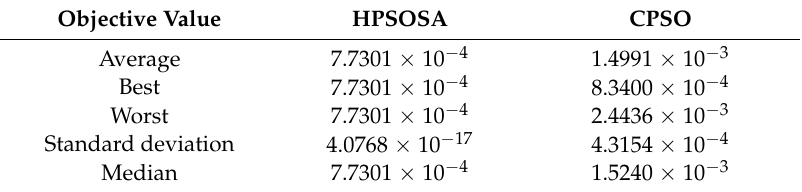
Table 2. Statistics of objective values ( RMSE ) for single diode PV model using